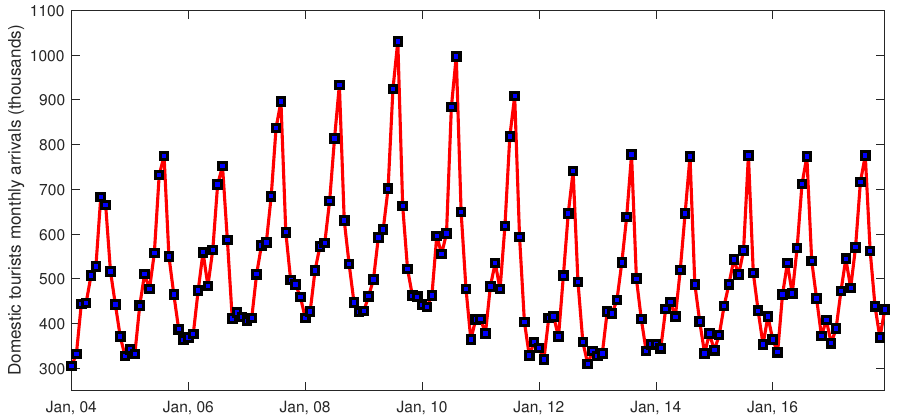
Figure 2. Monthly arrivals of domestic tourist from 2004 to 2017.